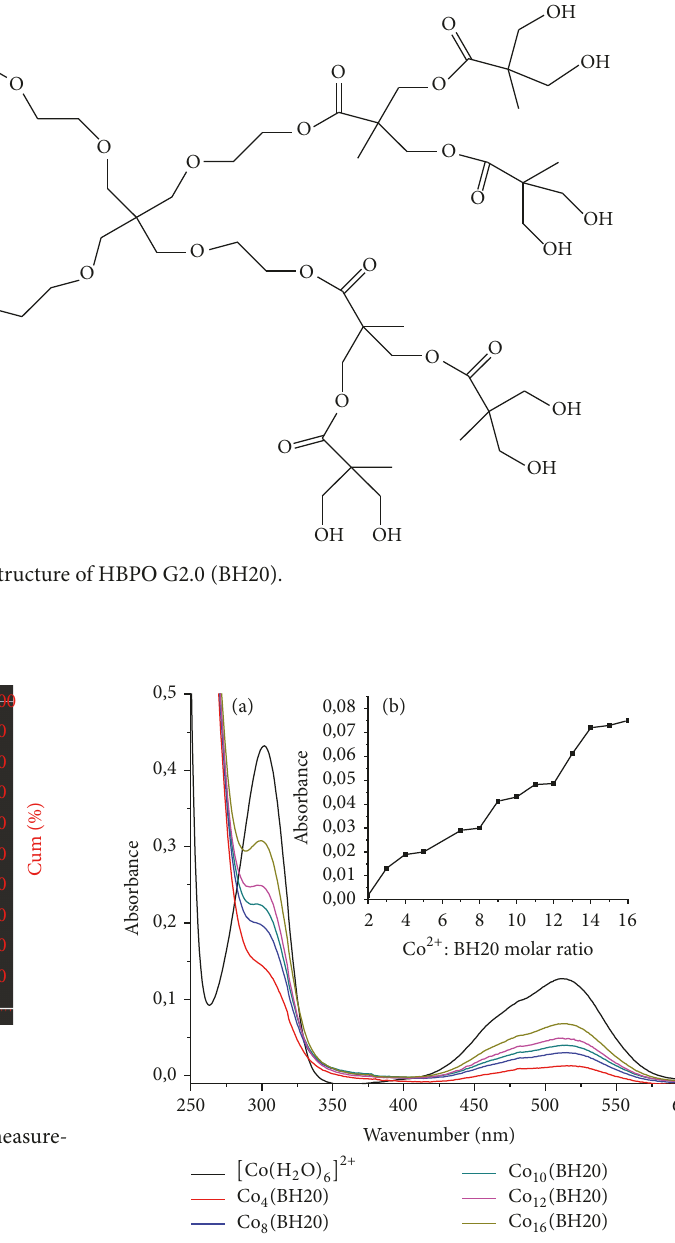
Figure 3: (a) UV-vis absorption spectra of b] 2+ -BH20 complex with different b] 2+ :BH20 molar ratio in aqueous solution. (b) Spectrophotometric titration solution of BH20 by CoCl 2 solution ( 𝑐 BH 20 = 0.1 mM, 𝑐 CoCl 2 = 0.1–1.6 mM, and 𝜆 = 518 nm) (b).